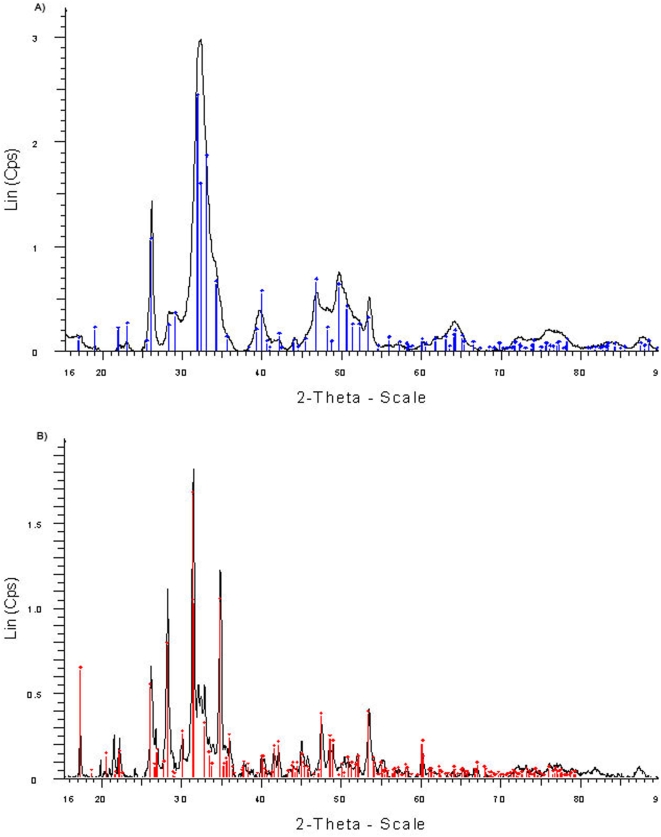
X-ray powder diffraction patterns of CA inclusions.(A) Hydroxylapatite − (Ca5(PO4)3OH) and (B) whitlockite − (Ca2(PO4)3) crystalline phases of CA.